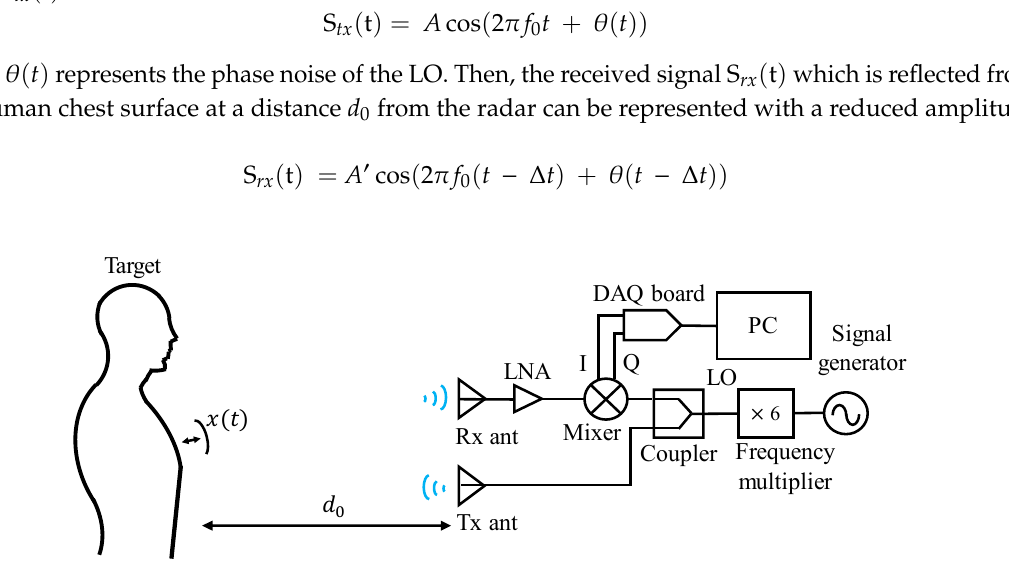
Figure 1. Block diagram of non-contact measurement of human vital sign using W-band continuous-wave (CW) radar.